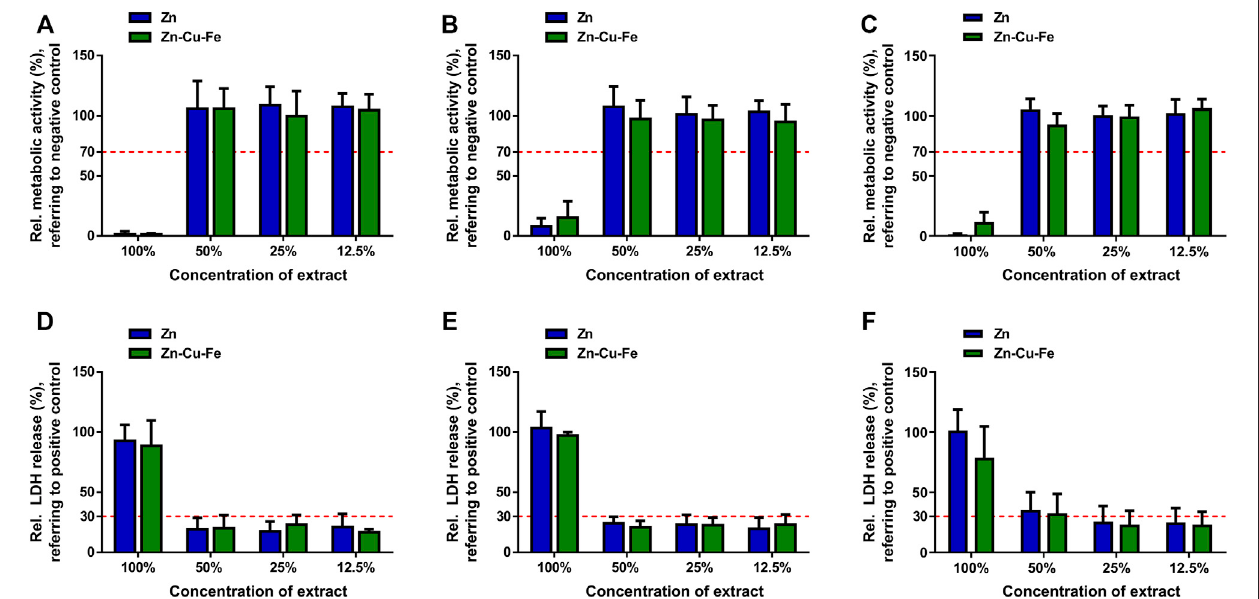
FIGURE6 | Quantitative results ofcytotoxicity evaluation for pureZn and Zn-Cu-Fe alloy. Relative metabolic activities ofRAW264.7 cells (A) , HUVEC cells (B) , and MC3T3-E1 cells (C) exposed to sample extracts for 24 h. The red dashed line (70% of the negative control) stands for the cut-off level between non-toxic and toxic